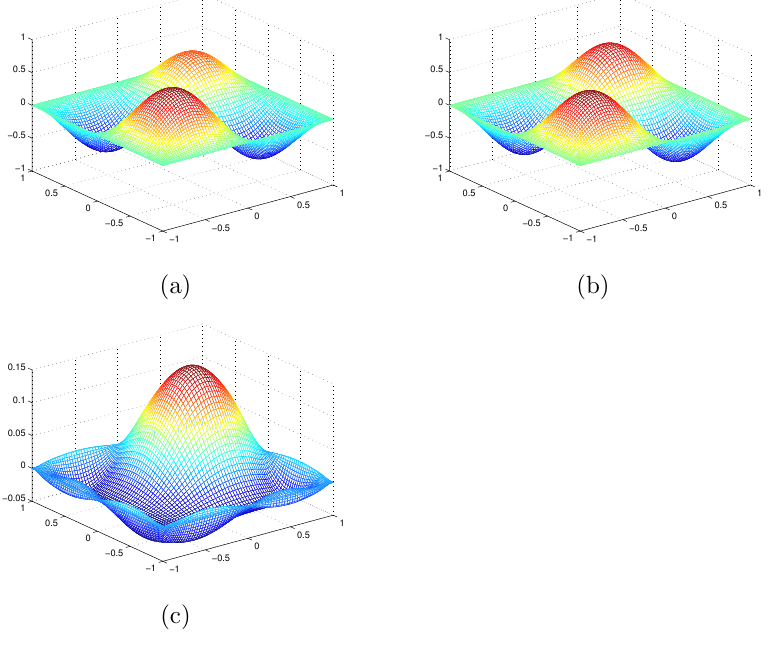
Figure 1. The solutions at T = 0 . 2: (a) CSFD solution, (b) ROESFD solution, (c) the relative error